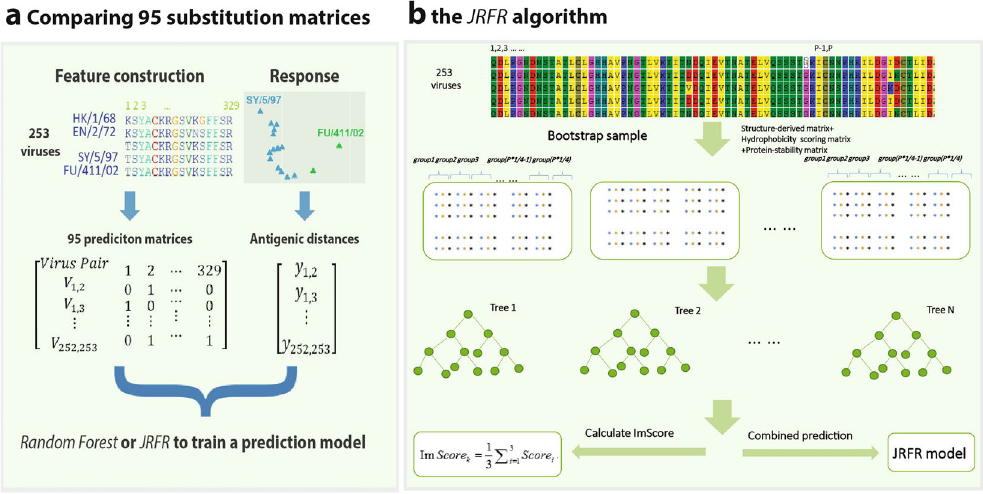
Figure 1. A flowchart to illustrate the computational framework in this